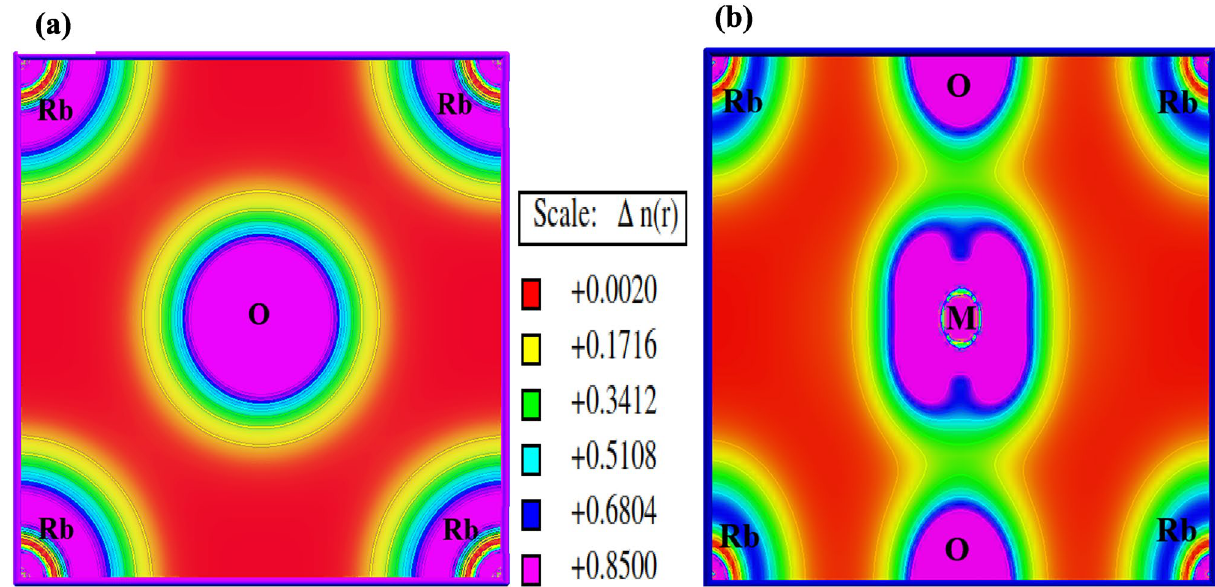
Figure 6. Electronic charge density distribution in RbMO 3 perovskites along ( a ) 100 and ( b ) 011